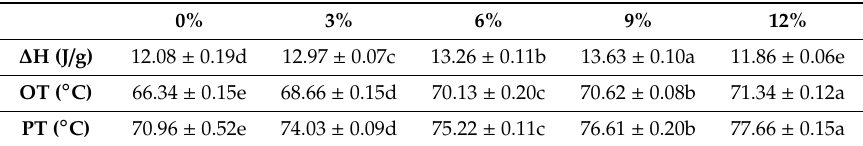
Table 1. DSC (di ff erential scanning calorimeter) properties of corn starch as a function of di ff erent levels of gum Cordia